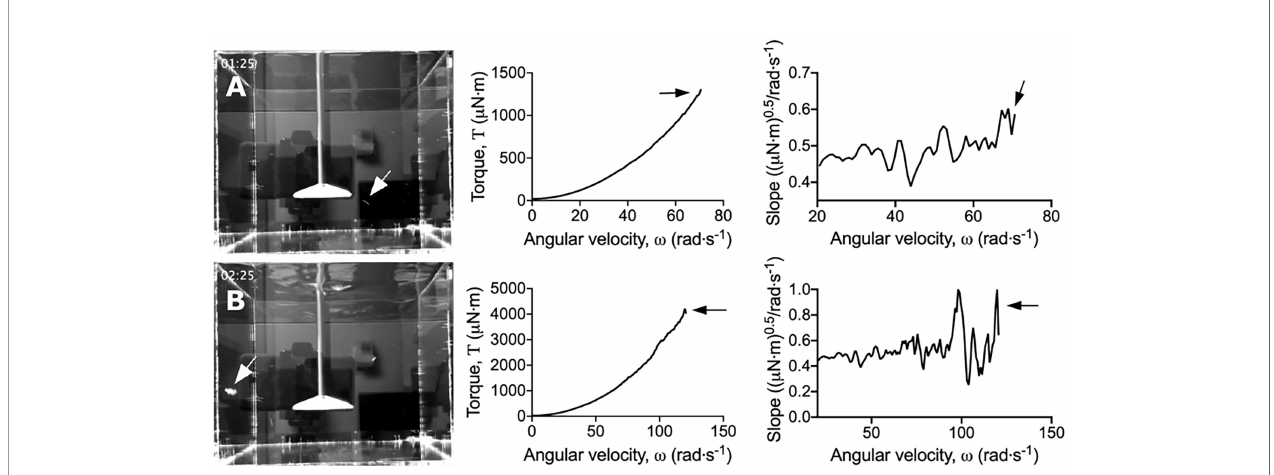
FIGURE 2 | Dips in the torque – angular velocity curve correlate to bio fi lm detachment events from the coupon. Stills taken from Movies S1 and S2 (left panel) depicting (A) small and (B) large bio fi lm detachment events. The torque – angular velocity curve (middle panel) and transformed linearized analysis (right panel) at each time is depicted. White arrows indicate detached bio fi lm and black arrows indicate the corresponding changes in the curve.